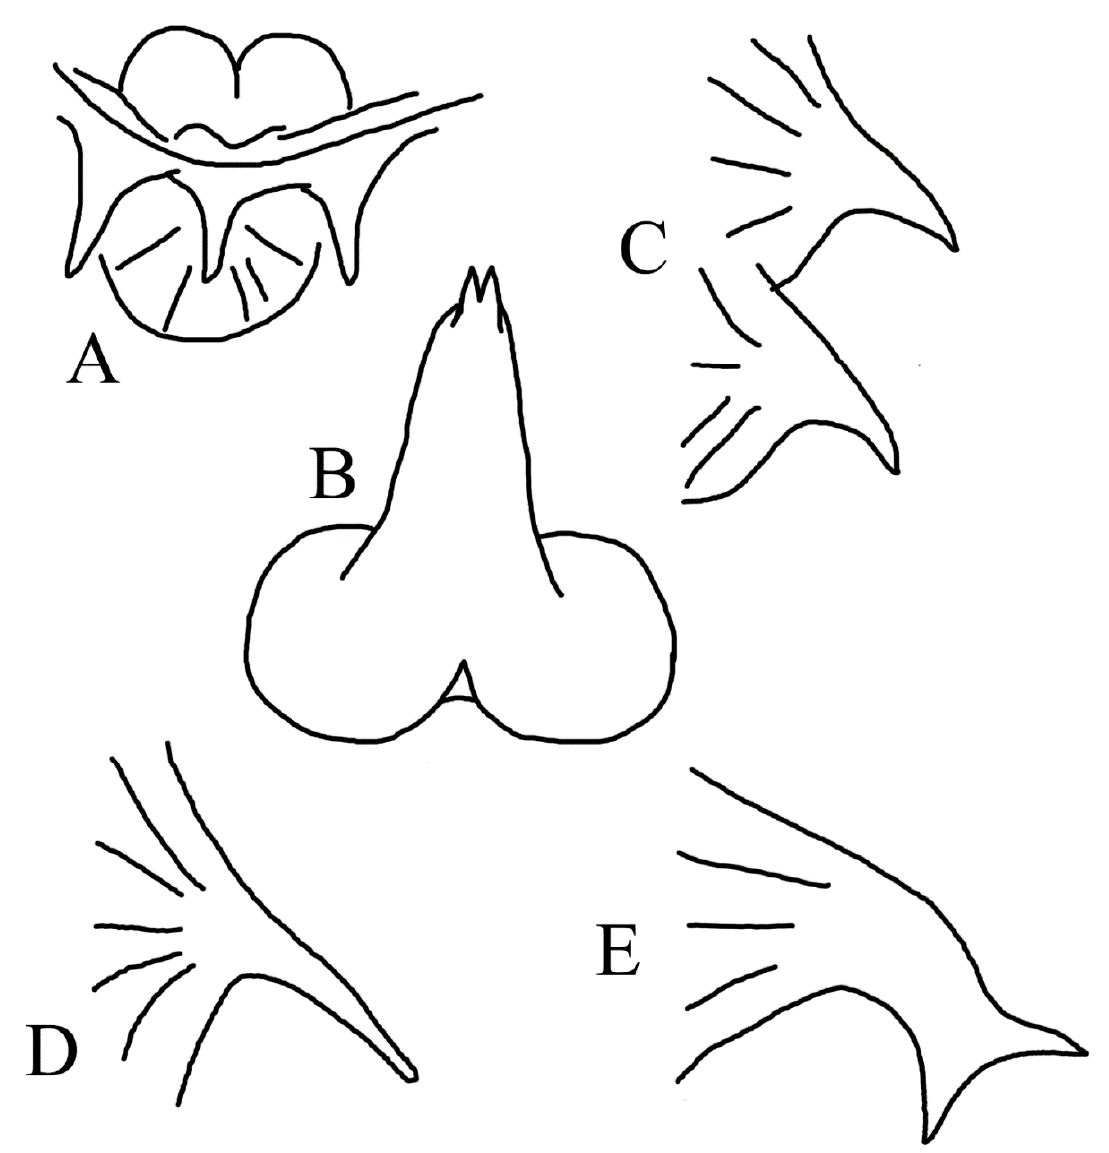
Figure 37. Esca and squamation of H. taiwanea sp. nov., from holotype. ( A ). Rostrum. ( B ). Esca. ( C ). Tubercles on disk margin. ( D ). Tubercle on tail. ( E ). Subopercular tubercle.